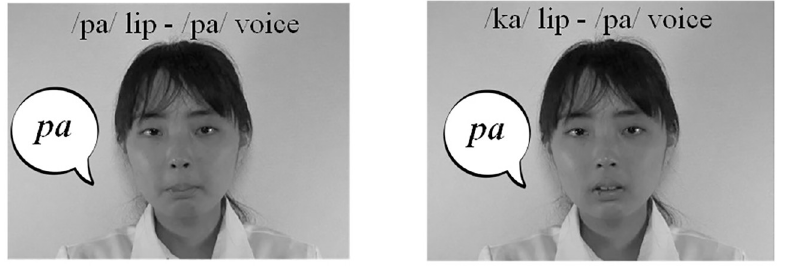
Fig 2. Sample images of stimuli in the phoneme perception